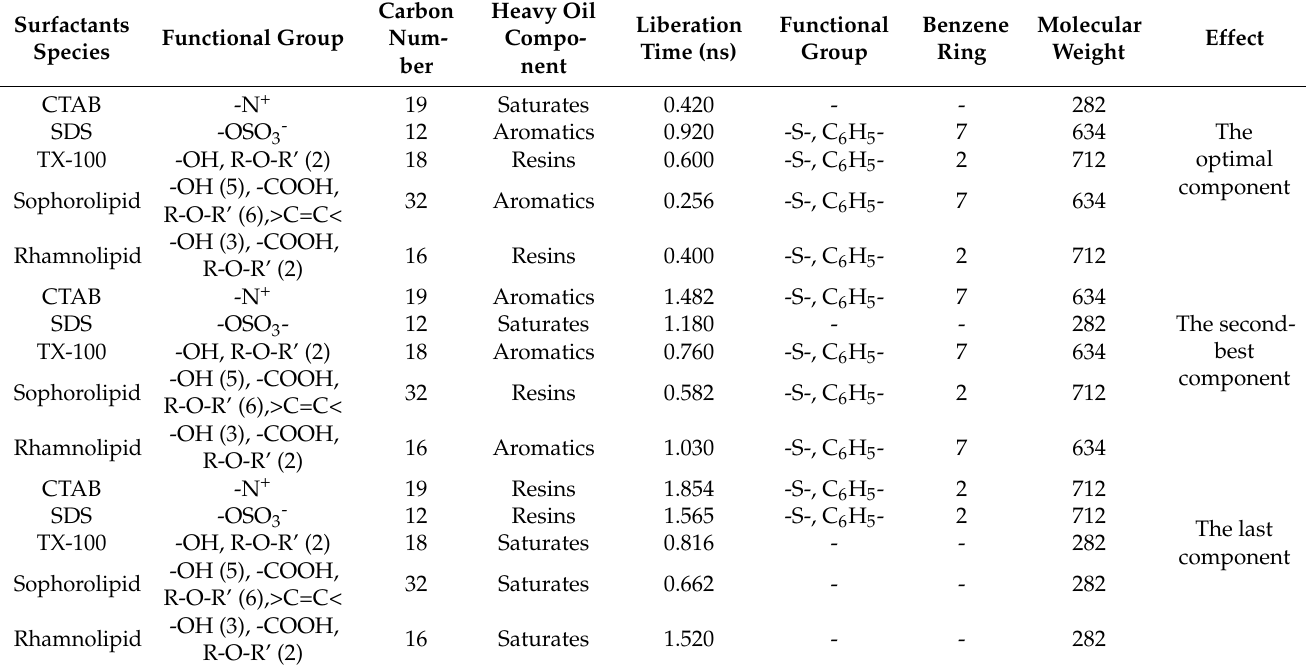
Table 8. Different surfactants’ effects on heavy oil components liberation